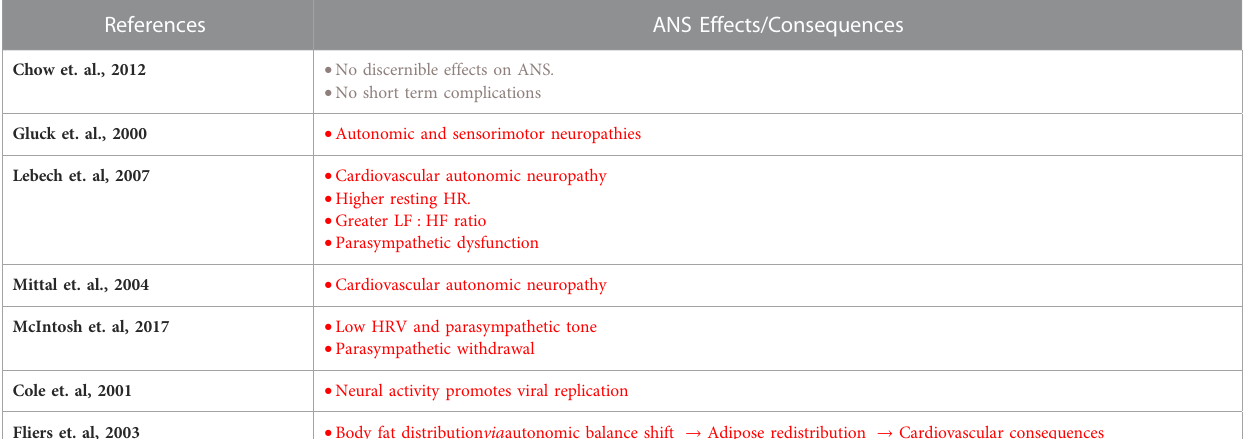
TABLE 3 Summary of ANS effects of HIV and cART